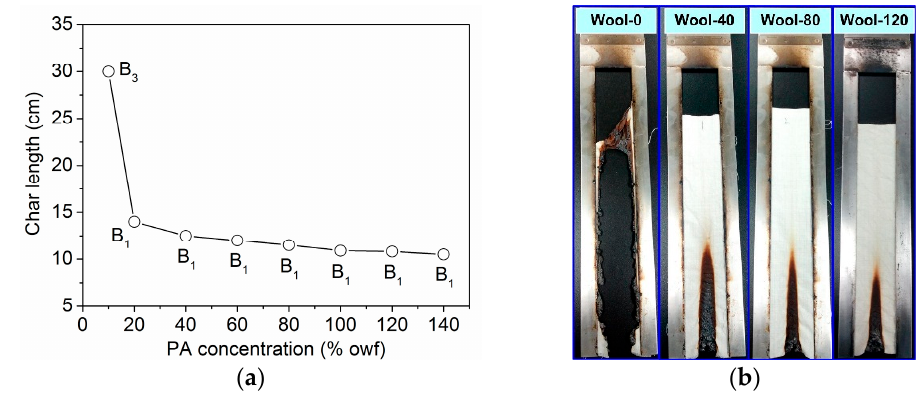
Figure 6. Char length ( a ) and photographs ( b ) of the treated wool fabrics after vertical burning